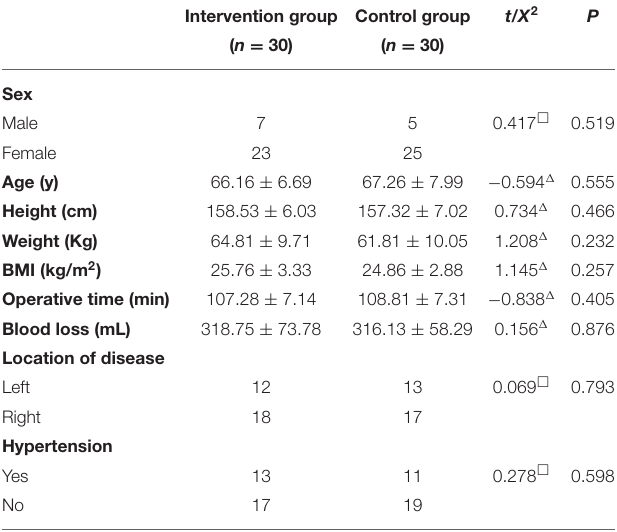
TABLE 1 | Characteristics of the study participants (x ± s).